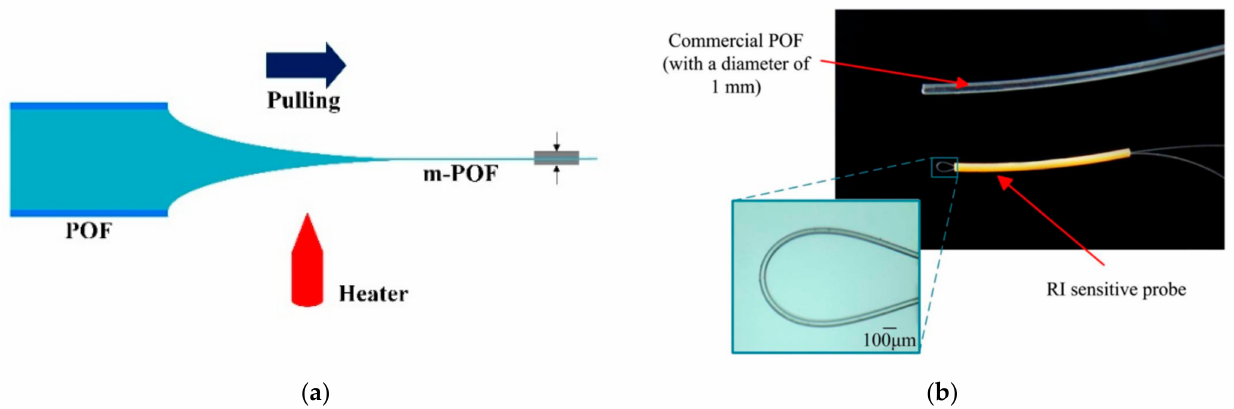
Figure 10. The schematic diagram of the directly drawing process of micro-POF from commercial POF ( a ), and the photo of the micro-POF ( b )